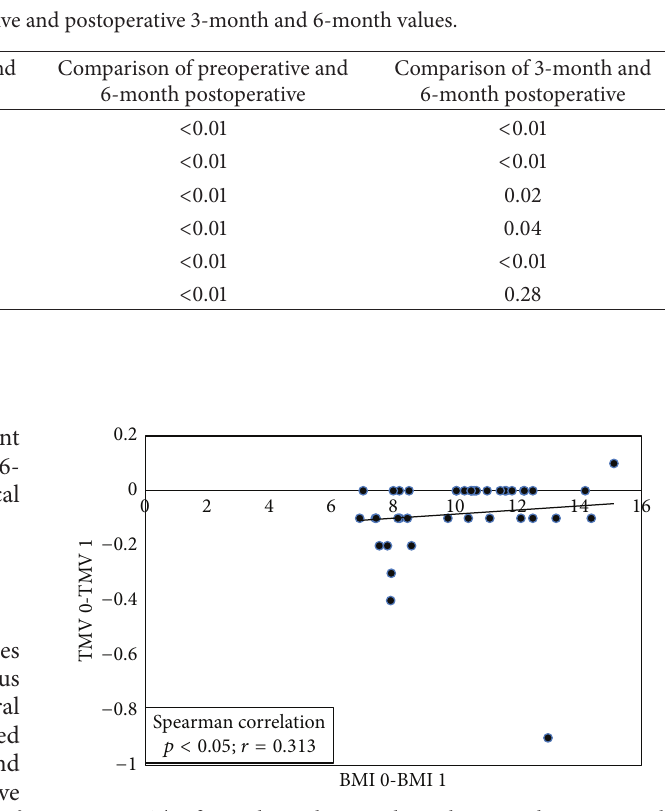
individuals have decreased nitric oxide (NO) levels, which could result in impaired dilatation of the vasculature